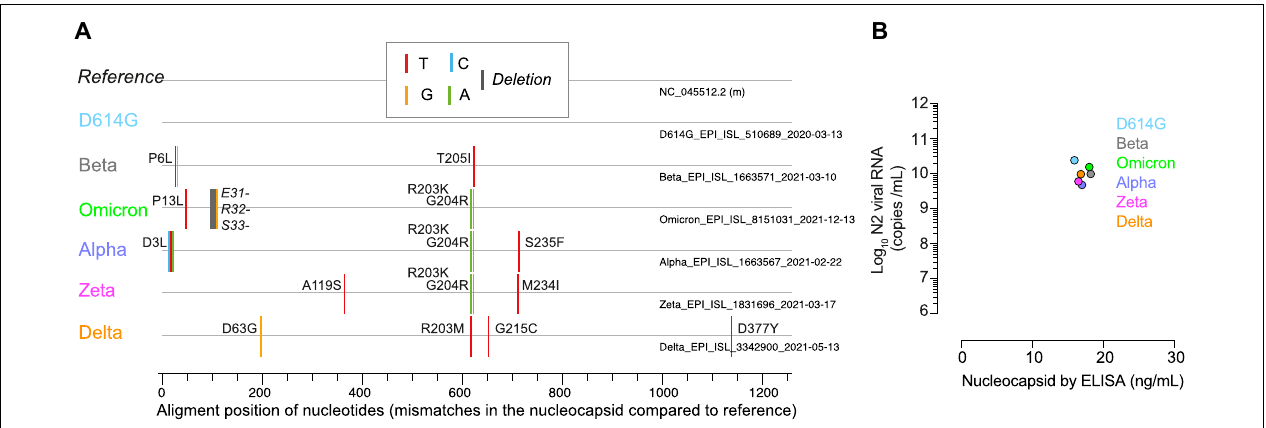
FIGURE 1 | Nucleocapsid mismatches and quantification of the SARS-CoV-2 variants. (A) Nucleotide mismatches or deletions (represented by the colored lines of the legend) and amino acid changes indicated by codon position sequenced in the nucleocapsid of distinct SARS-CoV-2 variants as compared to the original Wuhan virus (as reference). (B) Nucleocapsid concentration measured by qPCR (log 10 of viral N2 RNA copies/ml) and ELISA (ng of nucleocapsid/ml) for all variants analyzed at the first dilution tested in the Ag-RDTs.